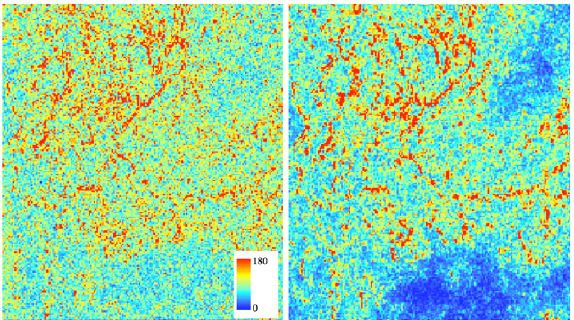
Figure 9 surface roughnesses derived from image texture for the same area, showing maximum variations over a 0.75m*0.75m window of 25cm HiRISE (left) and 6cm SRR image